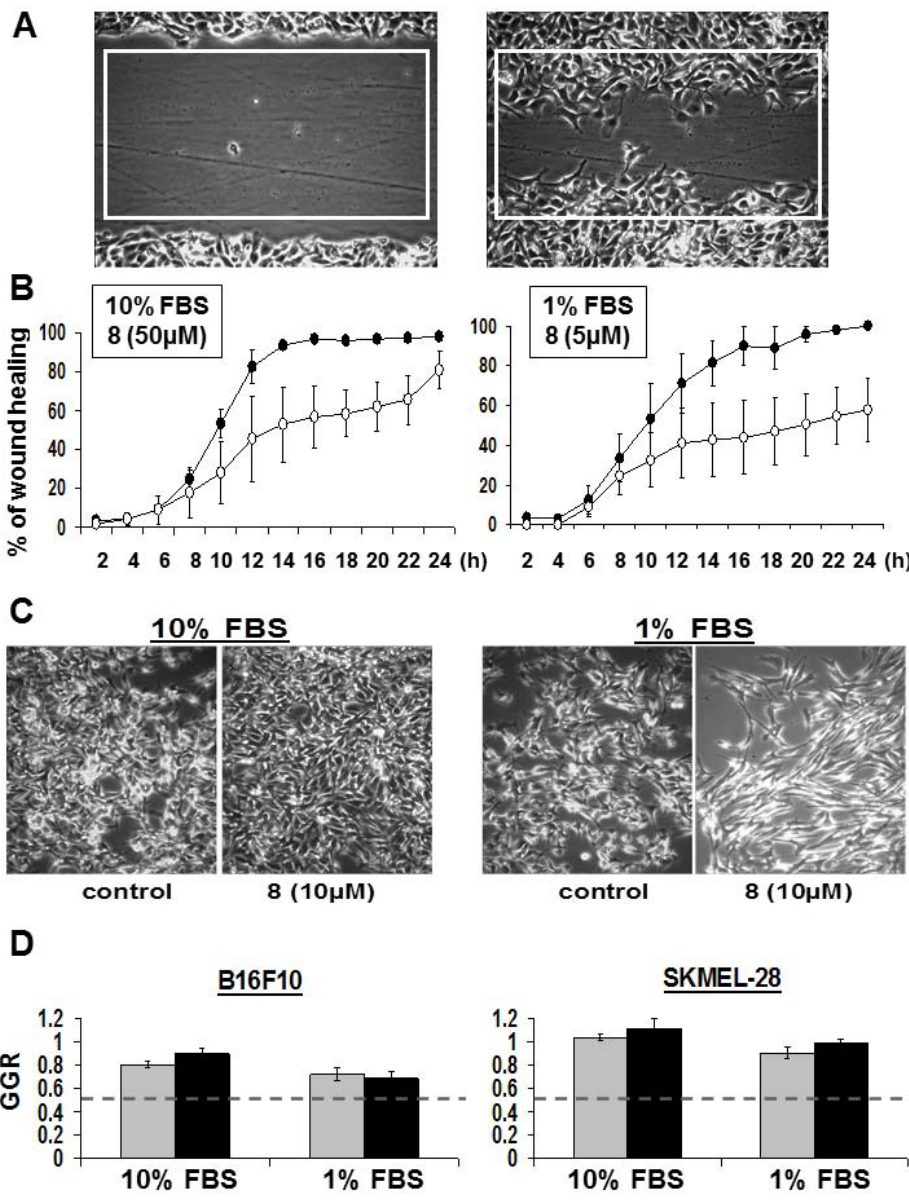
Figure 5. Anti-migratory effects of DBHB ( 8 ) on cancer cells. ( A ) Image of a wound made in confluent B16F10 cells at t = 0 h and 6 h after. Quantification of the area of the white rectangle healed over time is shown in ( B ) for cells cultured in 10 vs. 1% FBS. Black dots: control; open dots: DBHB treated condition at 50 µM or 5 µM as